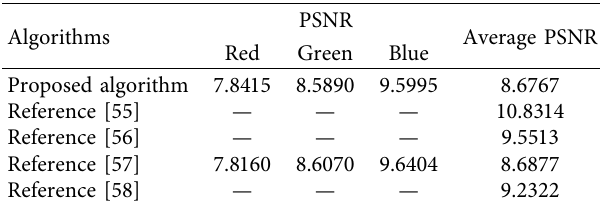
Table 6: PSNR results between the proposed algorithm and other algorithms